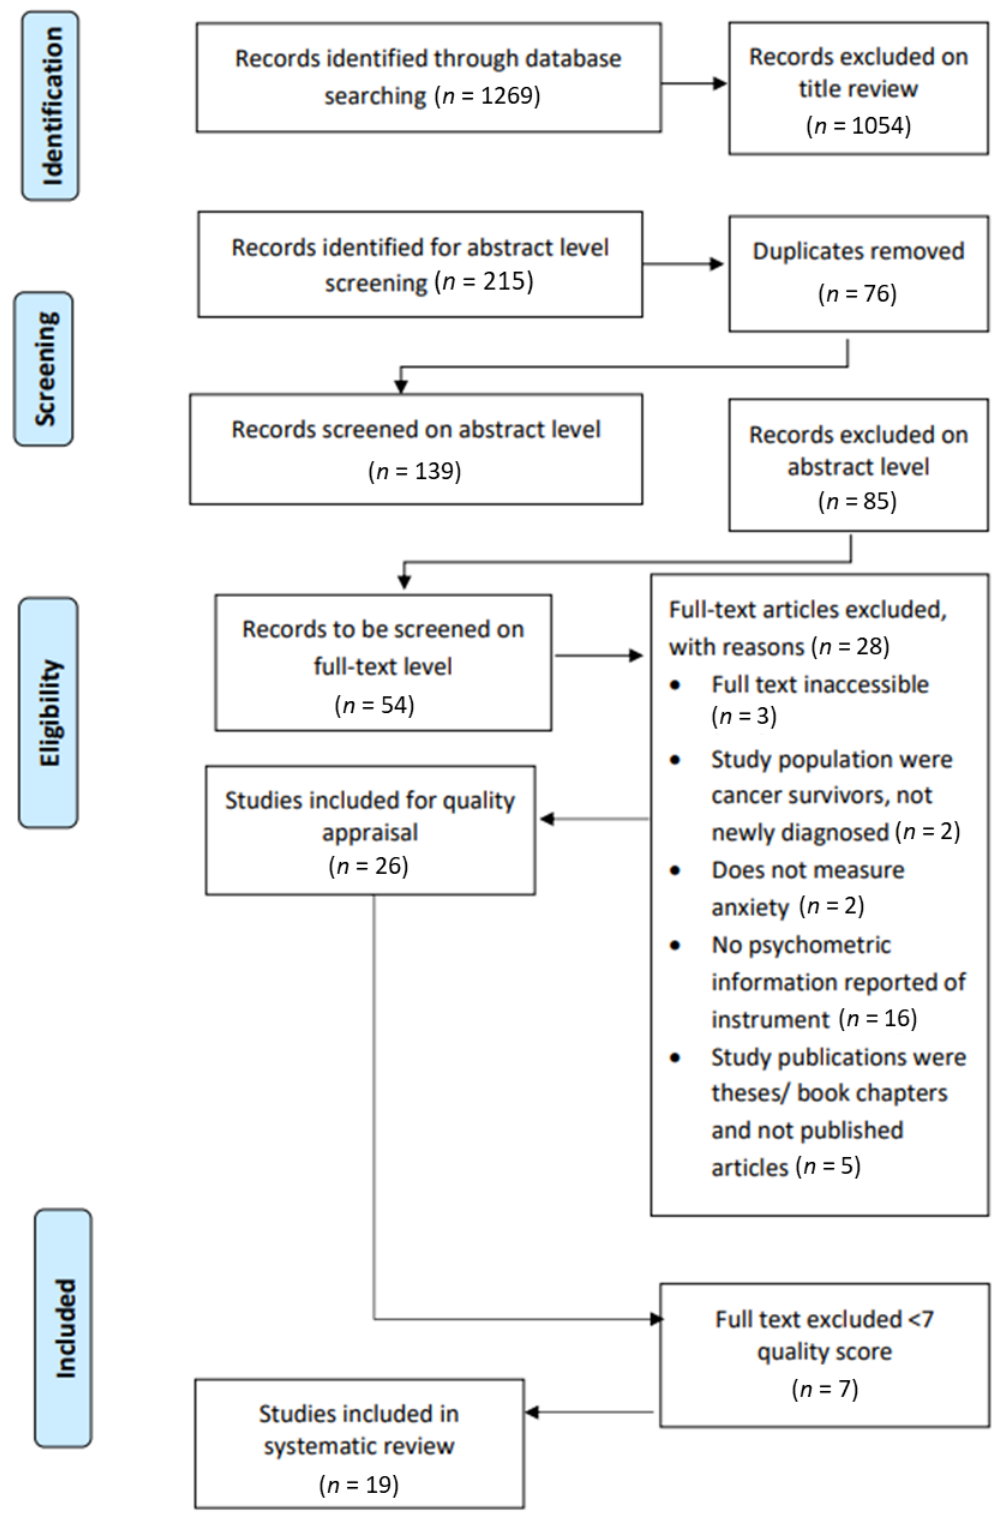
Figure 1. Preferred Reporting Items for Systematic Reviews and Meta-Analyses (PRISMA) flow diagram of the selection process.